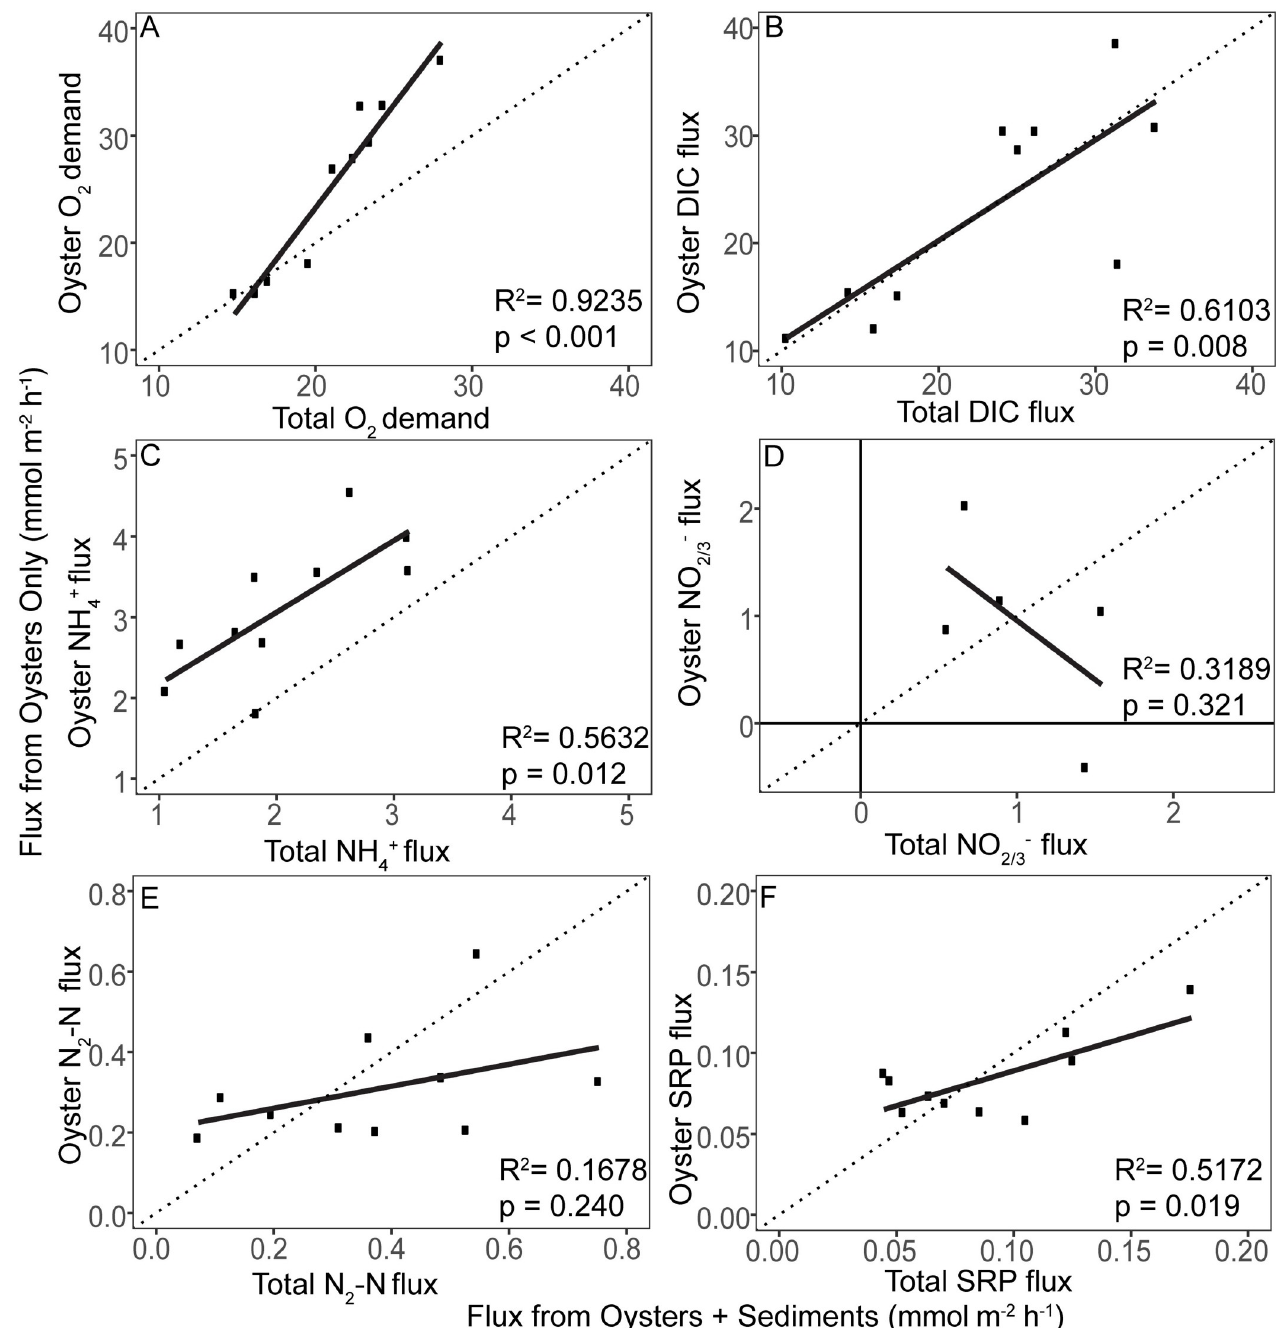
Fig 3. Regressions of fluxes from oyster clumps against those from reef segments. Regressions of (a) oxygen demand (b) DIC (c) NH 4+ (d) NO 2/3- (e) N 2 (f) and SRP fluxes. https://doi.org/10.1371/journal.pone.0209799.g003 overestimated at the lower end of reef segment measurements and underestimated at the higher end. Regression of clump denitrification rates indicated a marginally significant posi- tive relationship with oyster clump biomass (p = 0.07, R 2 = 0.36; Fig 4E).